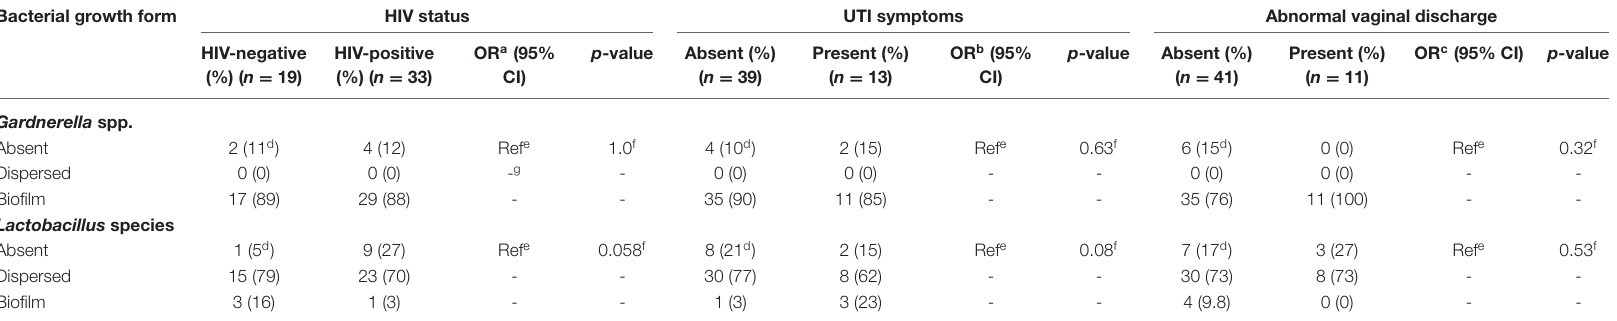
TABLE 5 | Association of growth forms of Gardnerella spp. and Lactobacillus species in relation to clinical characteristics in BV-positive women (Nugent scoring). Bacterial growth form